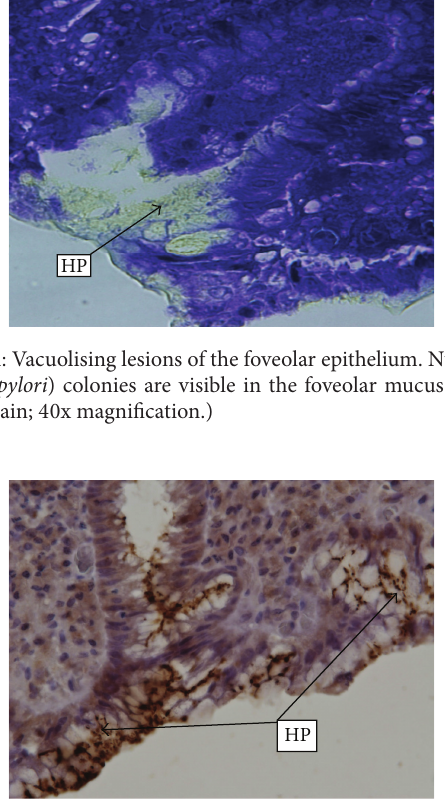
Figure 2: Numerous HP colonies on the surface of the foveolar epithelium. Epithelial cells present marked vacuolising lesions and destruction of the apical pole, giving the impression of intracellular HP invasion. (IHC, ACMo Anti-HP Biocare, clone BC 7; 40x magnification.)